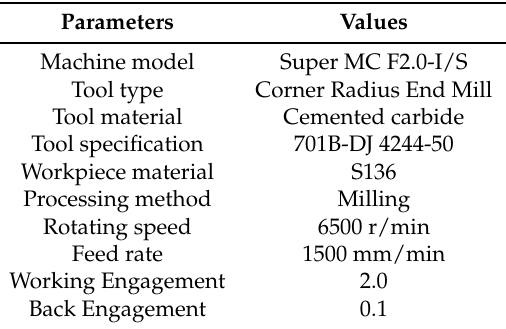
Table 1. Experimental